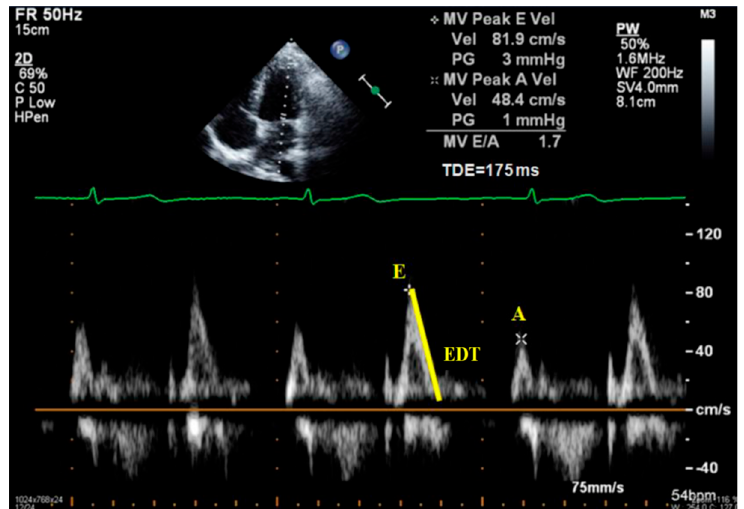
Figure 3. Echocardiographic assessment of mitral flow with pulsed Doppler in a patient in sinus rhythm. A: A wave velocity (cm/s); E: E wave velocity; EDT = E wave deceleration time.